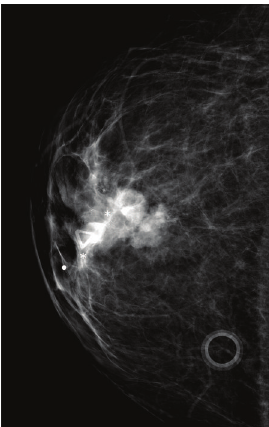
Figure 1: Right craniocaudal image demonstrates a highly suspi- cious retroareolar mass which correlates to the palpable abnormal- ity.